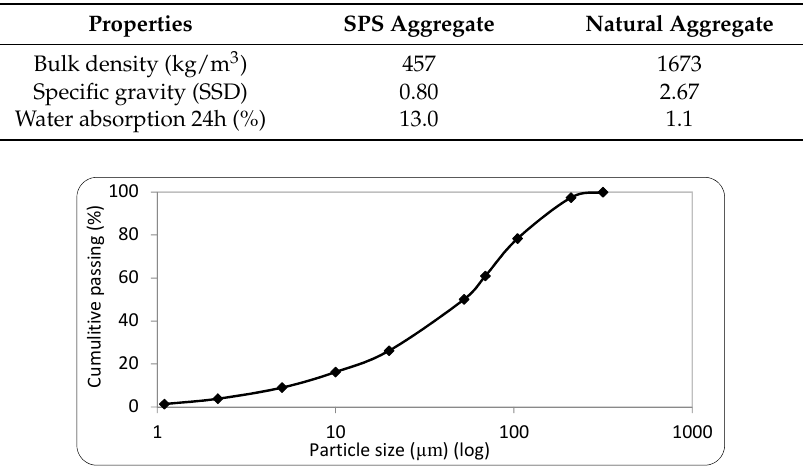
Figure 1. Sieving analysis of unprocessed FA.